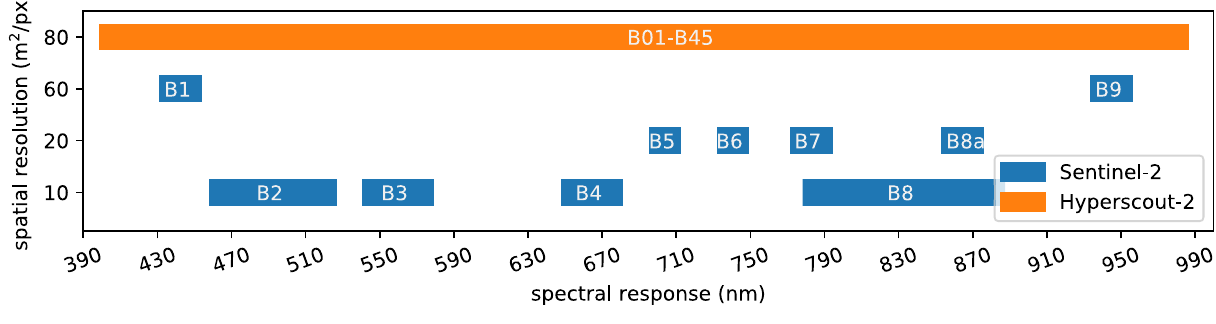
Figure 2. Spatial resolution and spectral response of Sentinel-2 and HyperScout-2